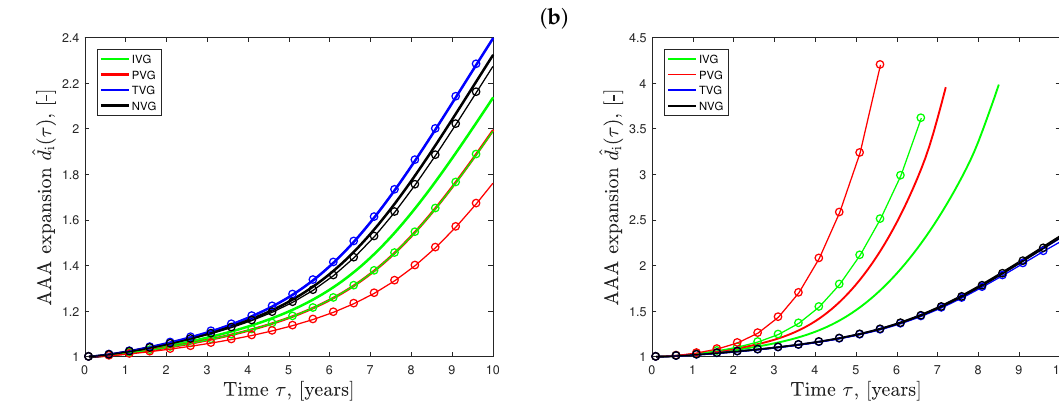
Figure 7. Effect of the initial volume fraction of elastin ( a ) and collagen ( b ) on the evolution of Abdominal Aortic Aneurysm (AAA) diameter ˆ d i = ( d i ) / d 0 over time τ . Isotropic Volume Growth (IVG), in-Plane Volume Growth (IVP), in-Thickness Volume Growth (TVG) and No Volume Growth (NVG) describe growth kinematics. ( a ) AAA expansion with initial elastin volume fractions of φ e = 0.12 (solid curves) and φ e = 0.18 (solid curves with circles); ( b ) AAA expansion with initial collagen volume fractions of φ i c = 0.075 (solid curves) and φ i c = 0.15 (solid curves with circles) prescribed in the